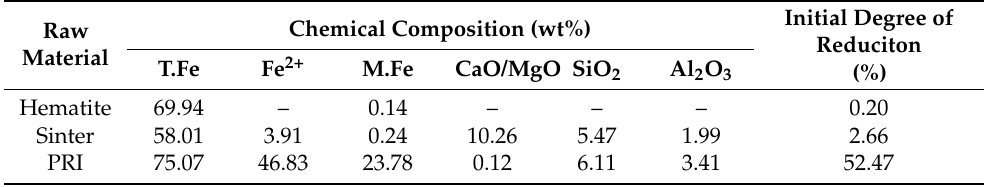
Table 1. Chemical analysis of raw materials used in the present